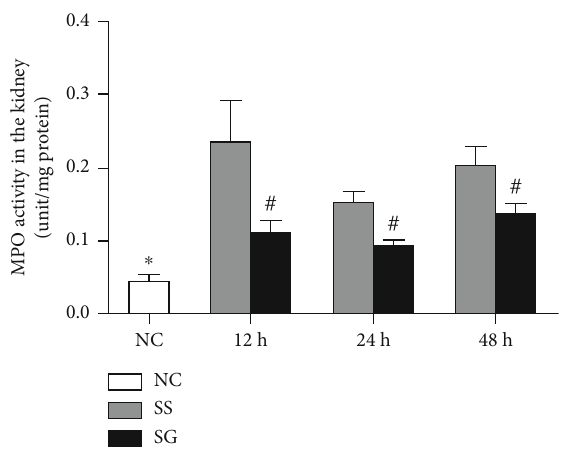
Figure 5: Myeloperoxidase (MPO) activity in kidney tissues. NC: normal control; SS: sepsis group with saline; SG: sepsis group with glutamine. Values are expressed as the mean ± SEM . n = 8 for each group at 12, 24, and 48h after cecal ligation and puncture (CLP). Di ff erences between 2 sepsis groups at the same time point were analyzed by t -test. The comparison among NC and the sepsis groups at three di ff erent time points were analyzed by a one-way analysis of variance (ANOVA) followed by Tukey ’ s post hoc test. ∗ Signi fi cantly di ff ers from other sepsis groups; # signi fi cantly di ff ers from the SS group at the same time point ( p < 0 : 05 ).